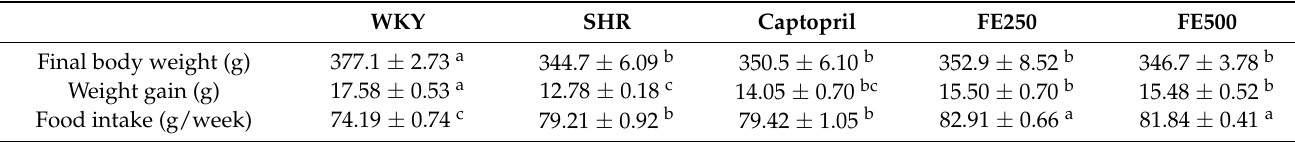
Table 1. Effects of FE supplementation on the growth performance of the WKYs and SHRs. WKY SHR Captopril FE250 FE500 Final body weight (g) 377.1 ± 2.73 a 344.7 ± 6.09 b 350.5 ± 6.10